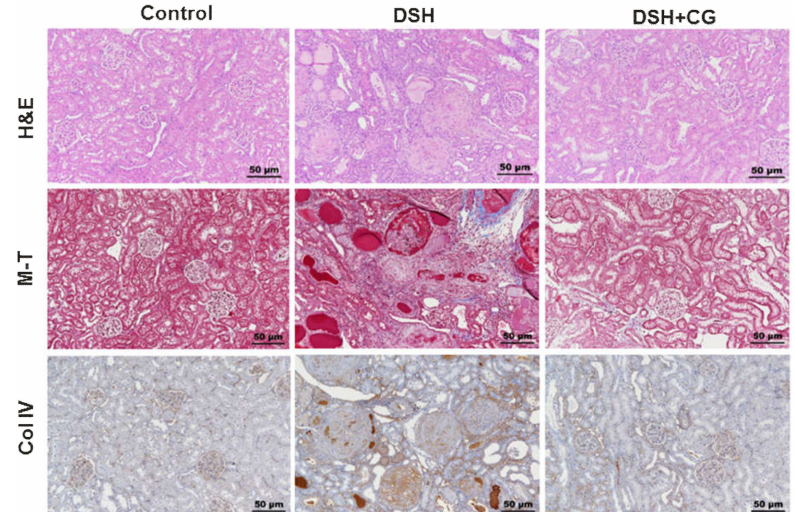
Figure 2. Hematoxylin and Eosin (H&E) stain, Masson’s trichrome (M-T), and collagen IV staining in the kidney cortex of experimental animals. Increased glomerulosclerosis and interstitial fibrosis were observed in deoxycorticosterone acetate (DOCA)-salt hypertensive (DSH) rats, which were attenuated by CG200745 treatment (DSH +